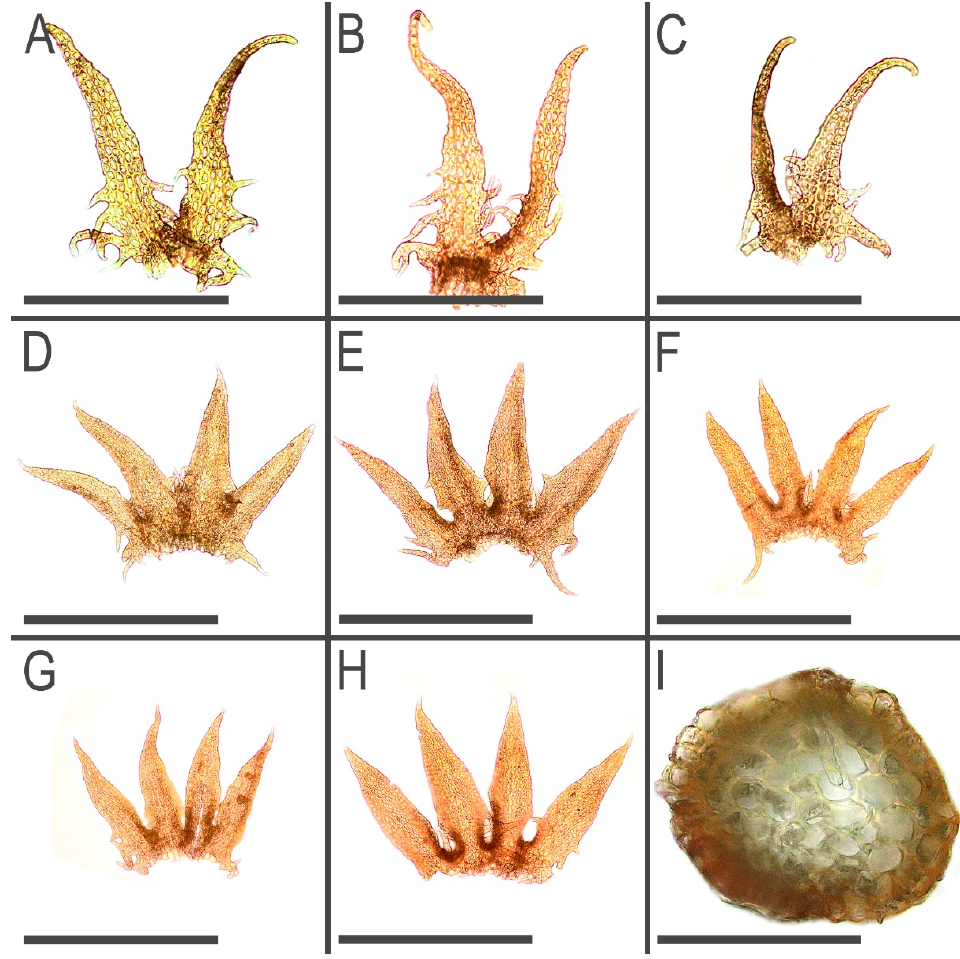
Figure 11. Tetralophozia pusilla (Steph.) Bakalin et Vilnet: A – C —underleaves; D – H —leaves; I —stem cross section. Scales: A – C —300 µm; D – H —500 µm; I —100 µm. All from J-88-40-15 (VBGI).